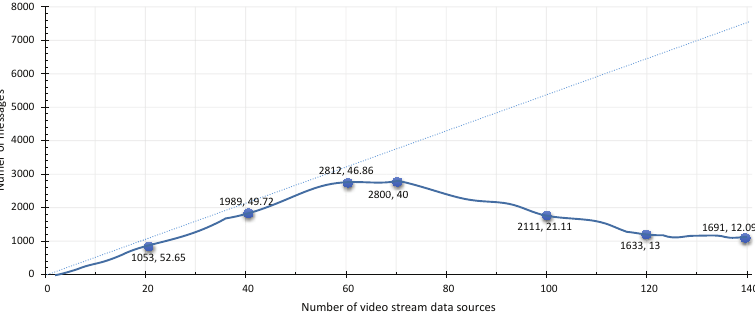
Figure 15. Stress testing of scalability of VSAS and VSP.